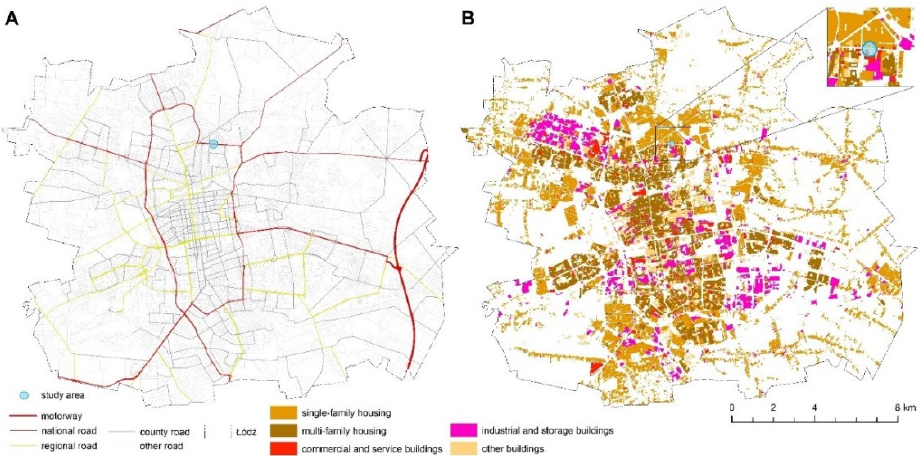
Figure 1. The location of the researched area against the background of the road network ( A ) and built-up areas in Łódź ( B ). Source: own elaboration based on the Database of Topographic Objects and OpenStreetMap.